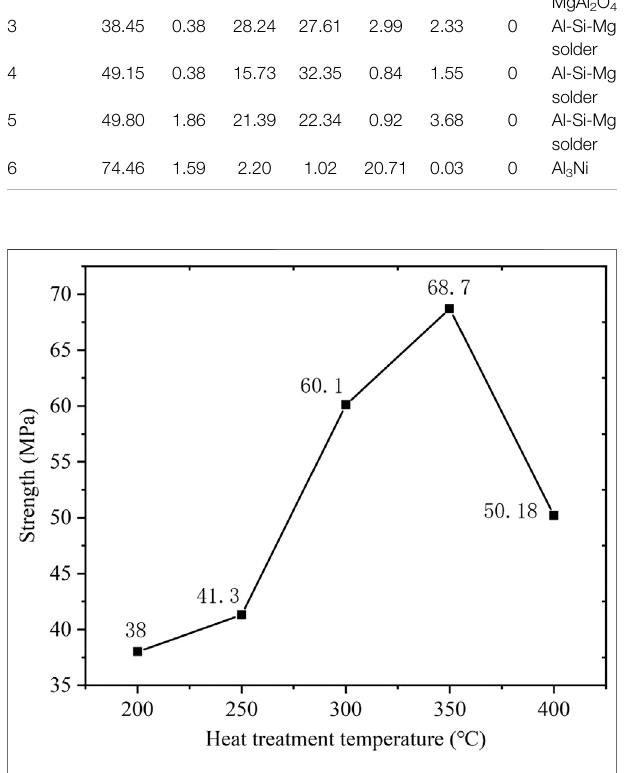
FIGURE 8 | Strength of the Al 2 O 3 (Ni) ceramic-aluminum alloy joints after 1 h heat treatment at different temperatures.